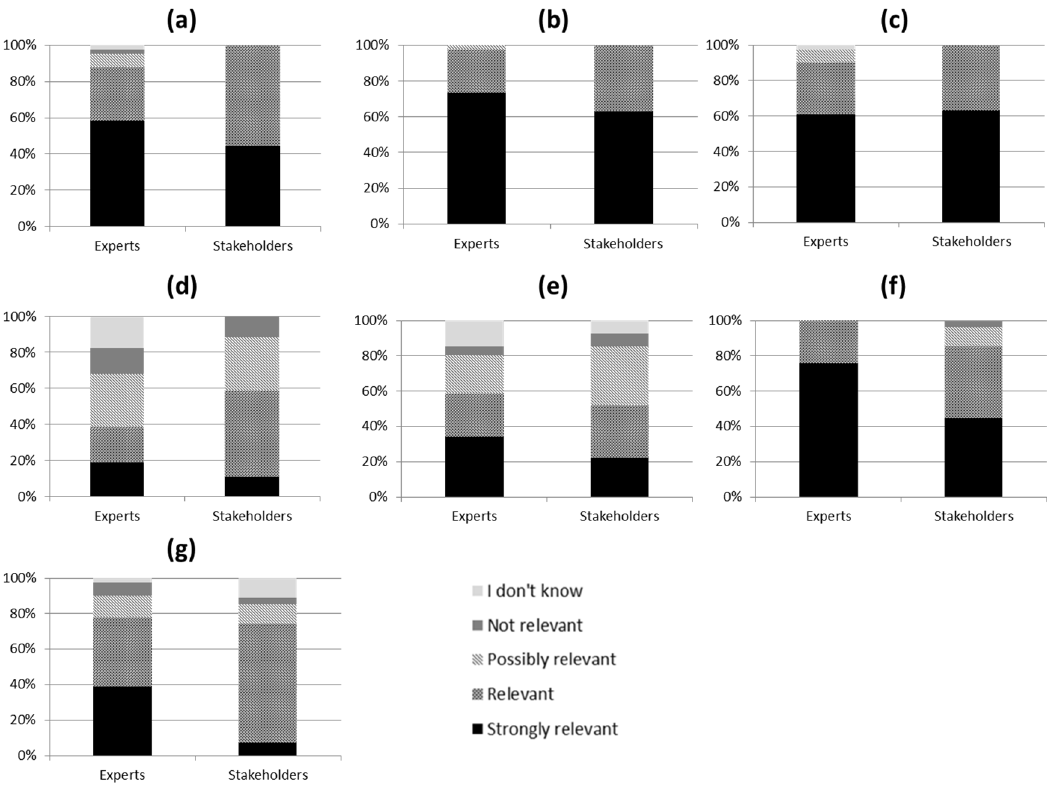
Figure 2. Sectors of interest: Experts’ versus stakeholders’ points of view: ( a ) households; ( b ) agriculture and livestock; ( c ) fishing/hunting/forest residues collection; ( d ) industry/transport/services; ( e ) energy; ( f ) environment and biodiversity; and ( g ) tourism.